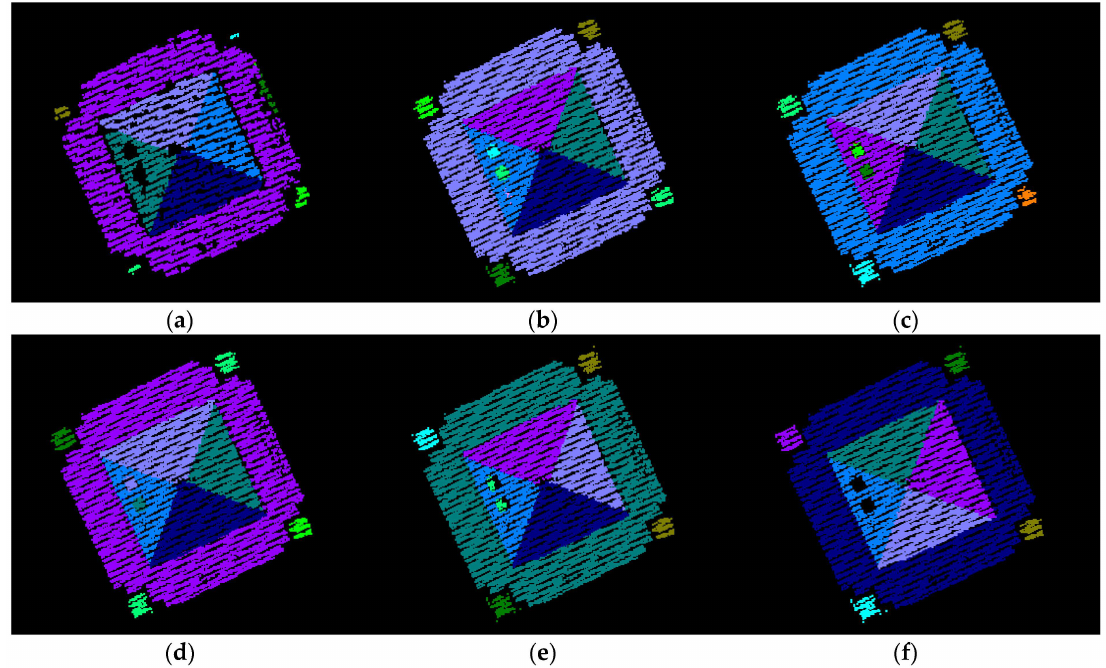
Figure 22. Segmentation results according to changing the threshold, searching radius, from 0.5 m to 5.0 m (the accuracy of the laser data is 0.15 m for all cases). Searching radius: ( a ) 0.5 m; ( b ) 1.0 m; ( c ) 2.0 m; ( d ) 3.0 m; ( e ) 4.0 m; ( f ) 5.0